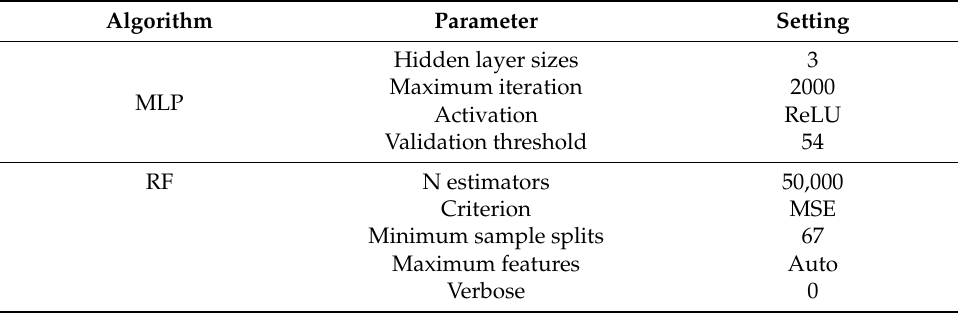
Table 3. ML algorithm parameter